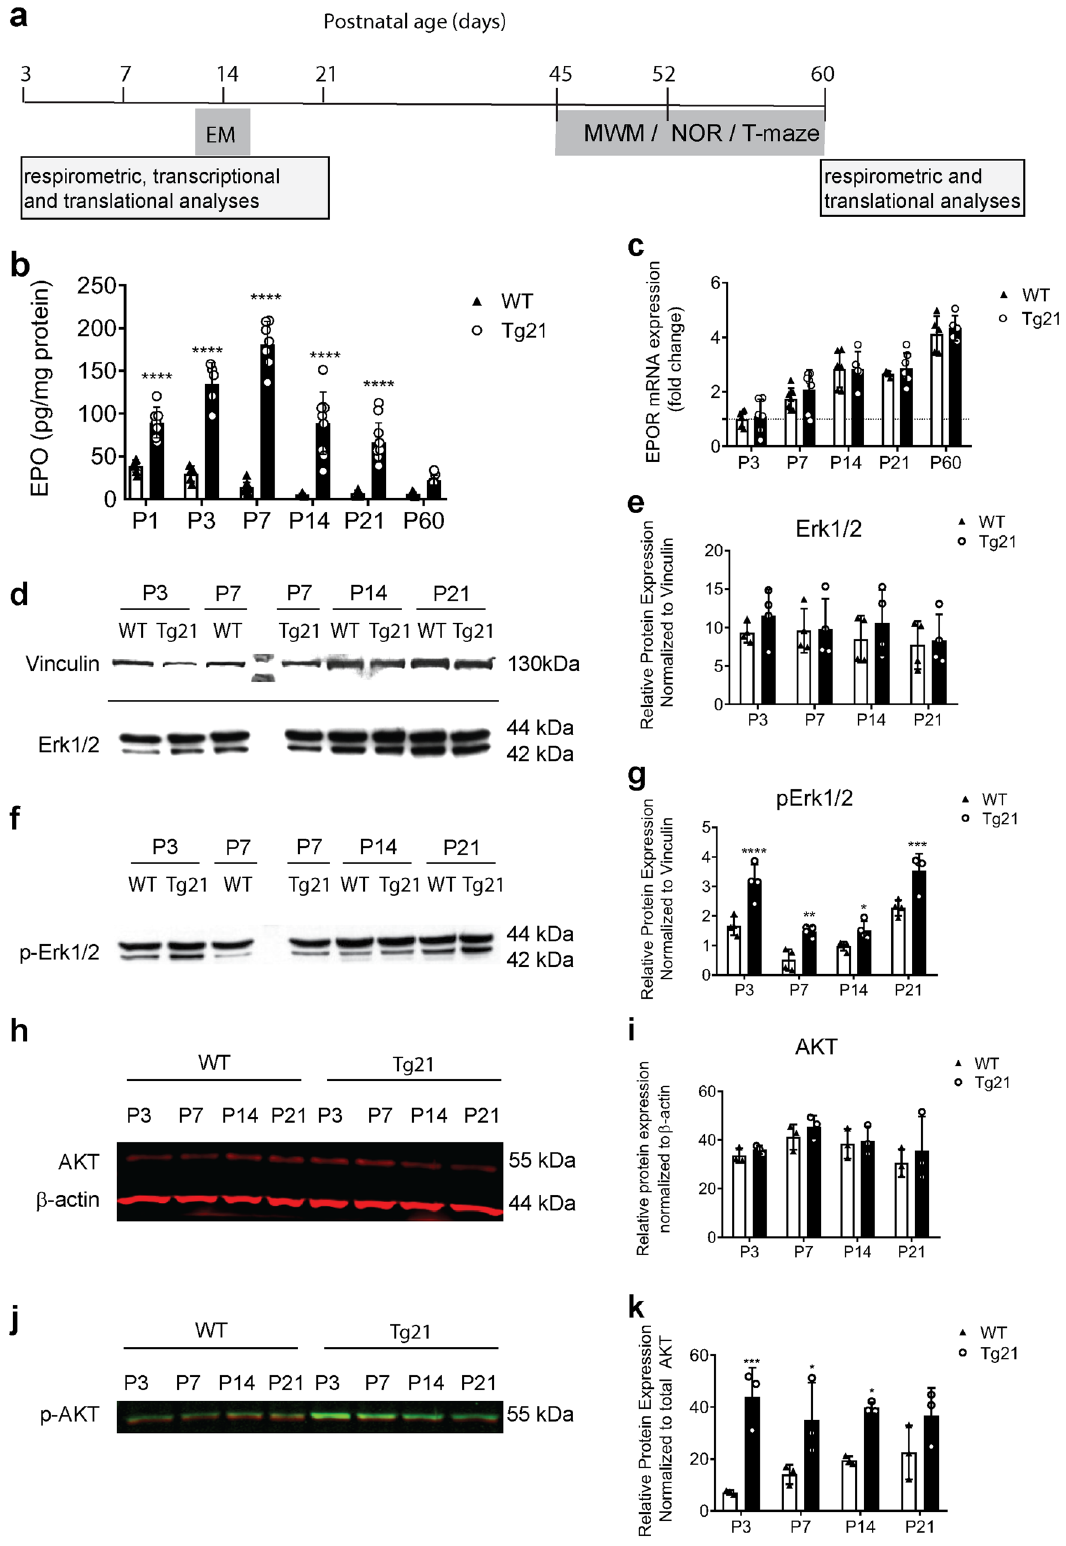
control of hippocampal EPO overexpression on Erk1/2 and AKT activation throughout postnatal development by western blot (Fig. 1d – k and Supplementary Fig. 3). Total Erk1/2 (Fig. 1d, e) and phosphorylated (p)Erk1/2 (Fig. 1f, g) band intensities were normalized to vinculin expression. There were no differences in total Erk1/2 protein between WT and Tg21 mice